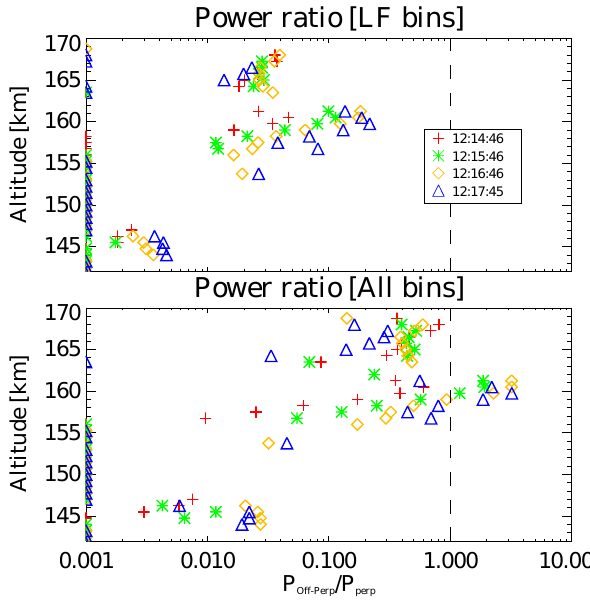
Fig. 4. Power ratio values using the off-perpendicular and perpen- dicular signals after correcting for the radar backscatter aperture dif- ference. Small values indicate large aspect sensitivity. Values close to 1 indicate isotropic scattering. The top/bottom row shows the re- sults of the low/all frequency (“LF”/“All”) data. Different times are indicated with different colors. Note that when there is only power in the perpendicular beam, we are using a number of